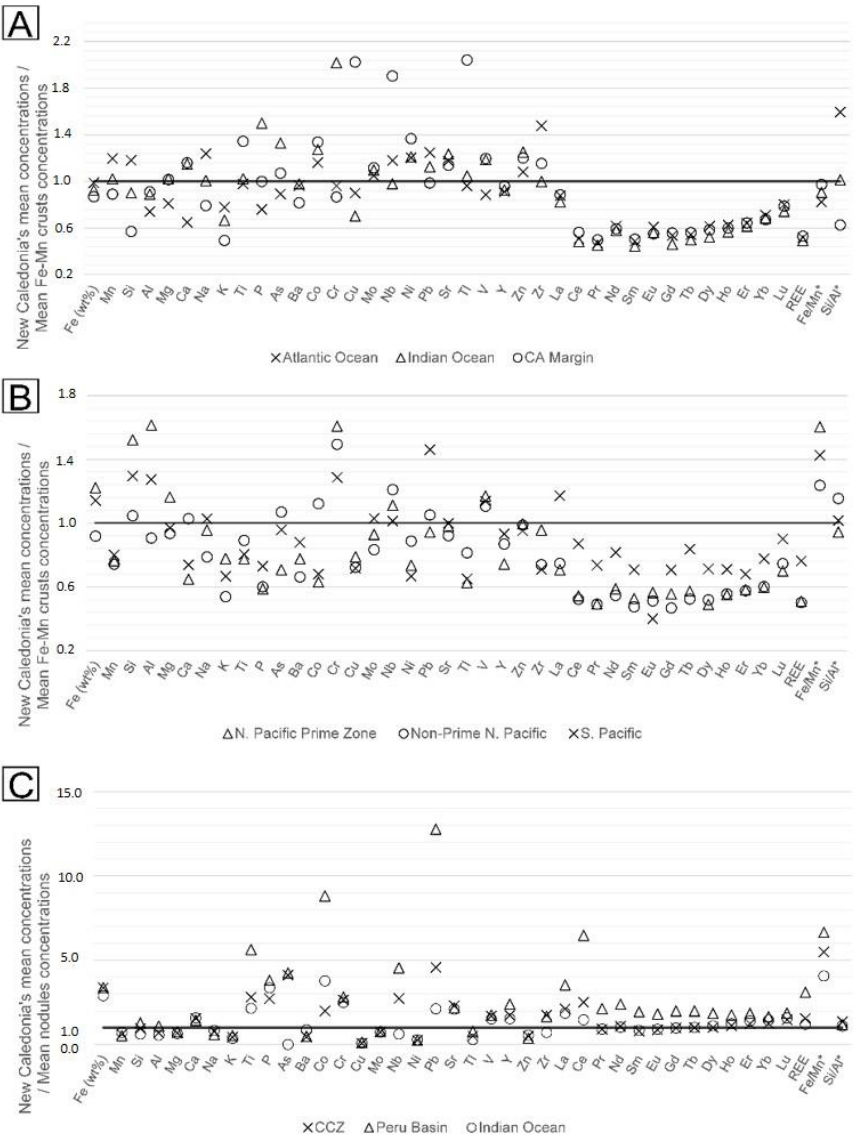
Figure 10. Element enrichment of New Caledonian crusts compared to ( A ) the California margin (CA), Atlantic and Indian oceans ’ Fe-Mn crusts, ( B ) the Pacific Ocean Fe-Mn crusts, and ( C ) polymetallic nodules from the Clarion – Clipperton Zone (CCZ), the Peru Basin and the Indian Ocean (after [1,76,77]). Values greater than 1 are enriched compared to other oceans crusts, whereas values lower than 1 are depleted. Fe/Mn* and Si/Al* ratios are calculated using mean ocean values.